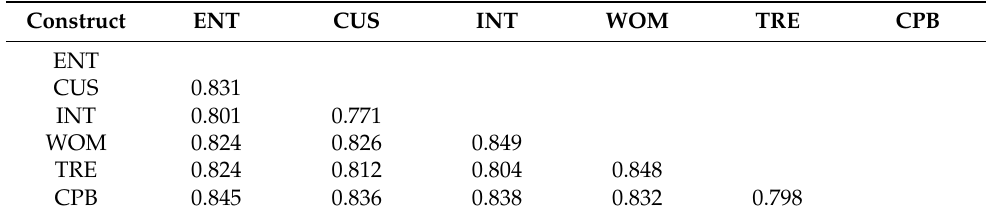
Table 3. Discriminant validity with